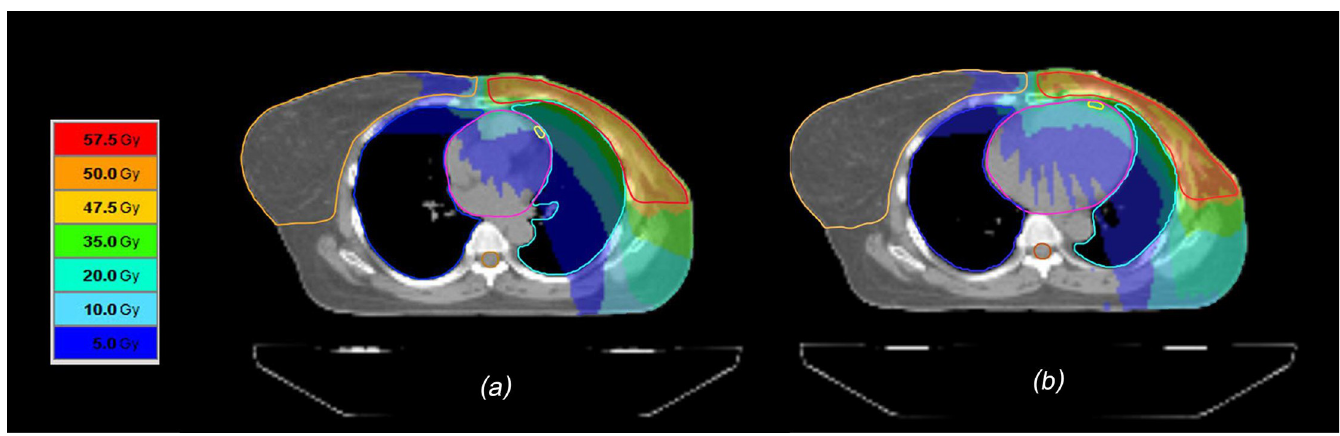
Fig 3. Comparison of Dose Distributions with ACSB (a) and FB Technique (b).